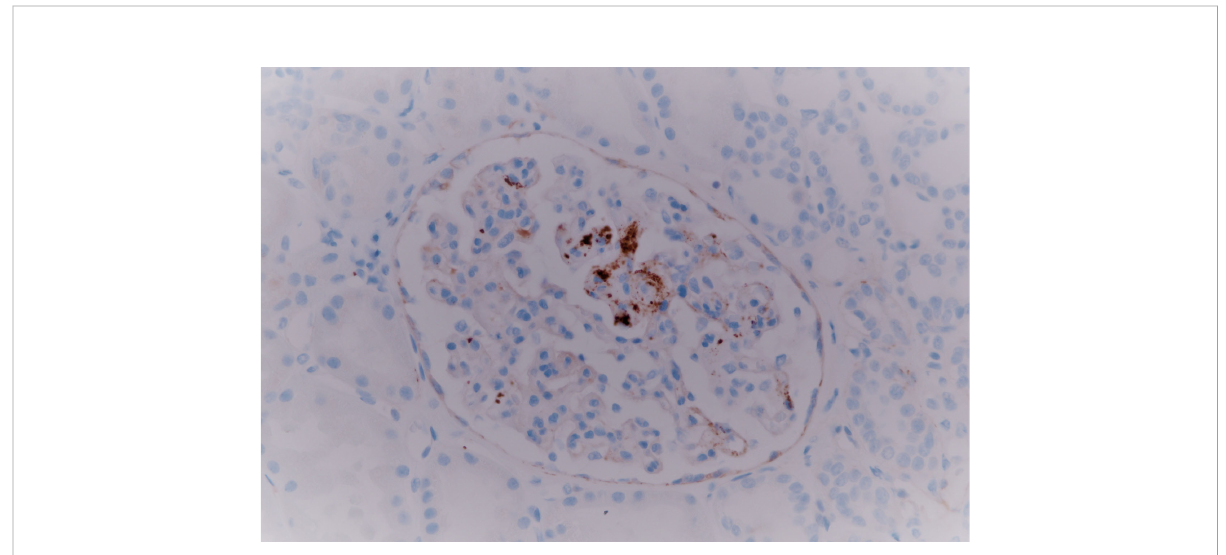
FIGURE 2 Segmental microthrombosis is highlighted by immunostain for CD61 (platelet-speci fi c glycoprotein) (CD61-400×).